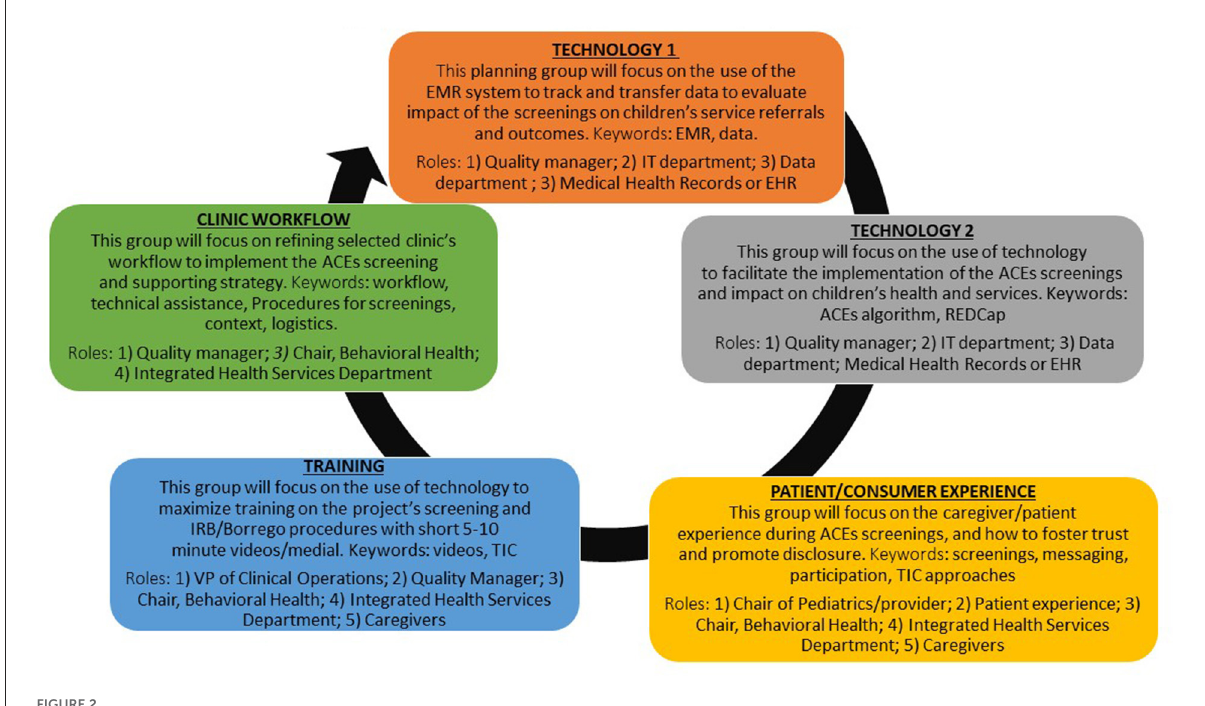
FIGURE2 ACEs screenings planning-mapping